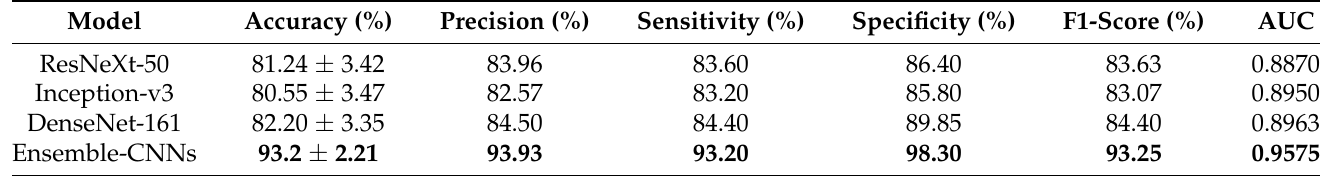
Table 10. The experimental results of the validation data of our proposed five-class COVID-19 database.